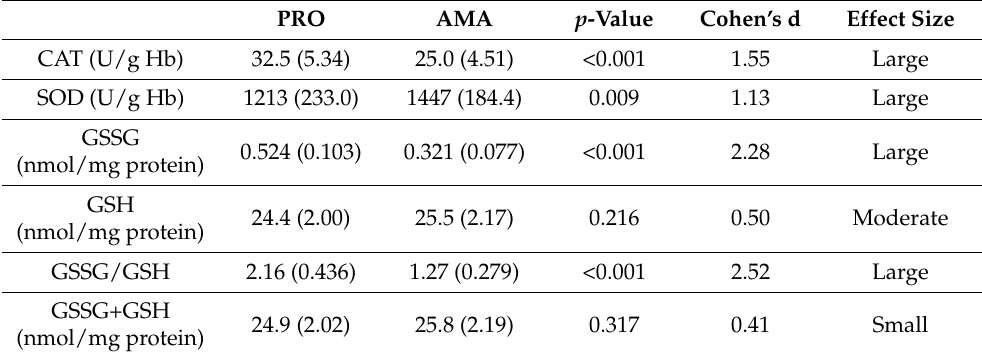
Table 2. Endogenous antioxidant enzymes from professional and amateur cyclists.